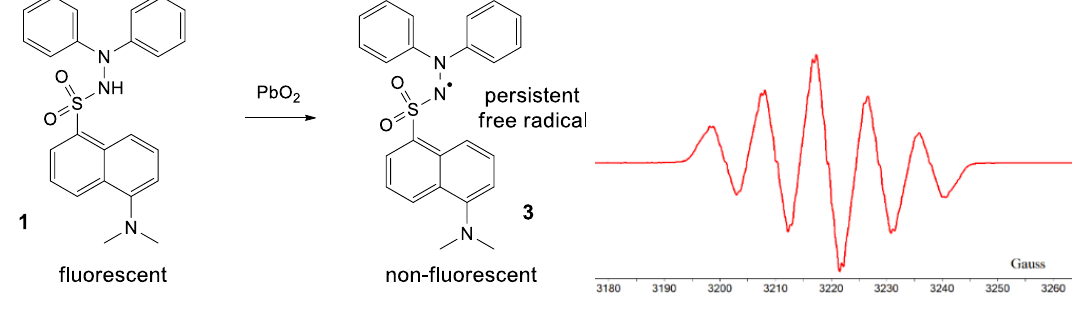
Figure 8. Formation of 3 and its ESR spectrum.